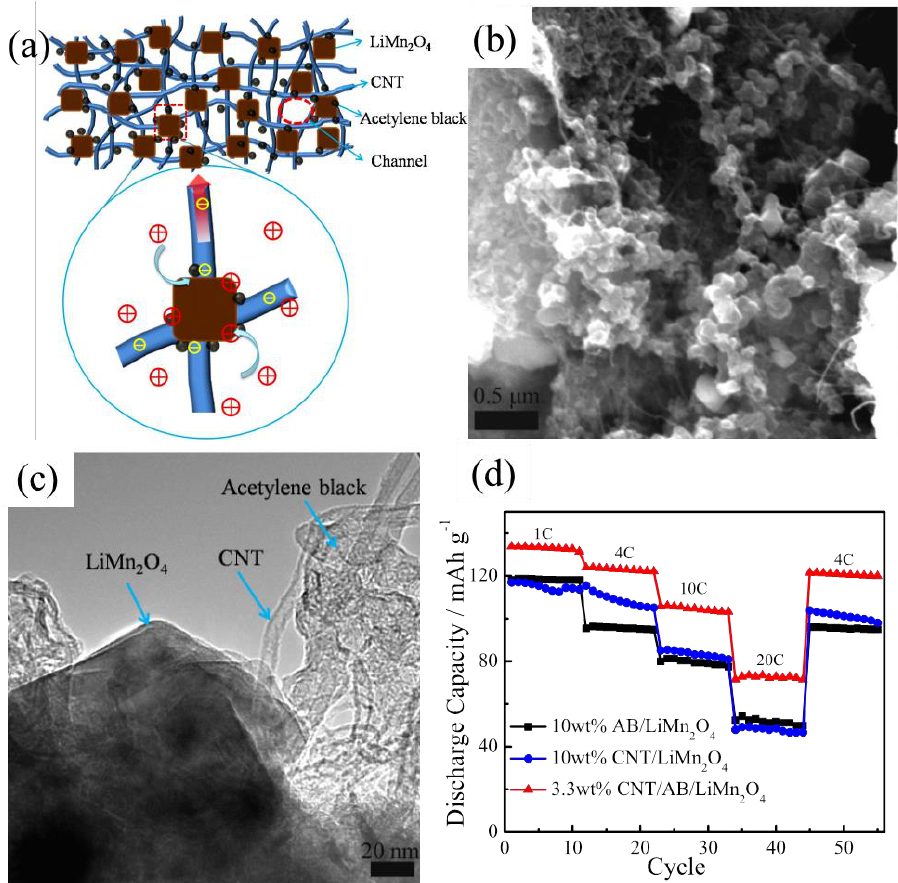
Figure 6. ( a ) Schematic illustration of CNT/AB/LiMn 2 O 4 electrode; ( b ) SEM; and ( c ) TEM images of the 3.3 wt % CNT/AB/LiMn 2 O 4 electrode; and ( d ) rate capability of the 3.3 wt % CNT/AB/LiMn 2 O 4 , 10 wt % CNT/LiMn 2 O 4 , and 10 wt % AB/LiMn 2 O 4 electrodes (modified from Ref. [68] with permission from Springer).